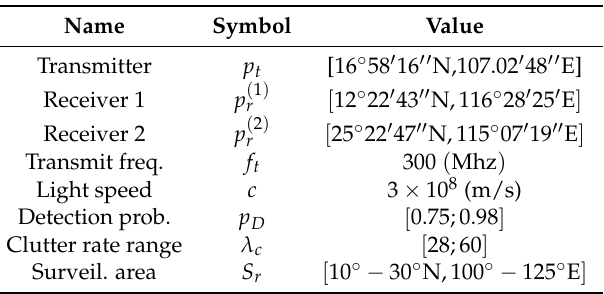
Table 3. Parameters of observation